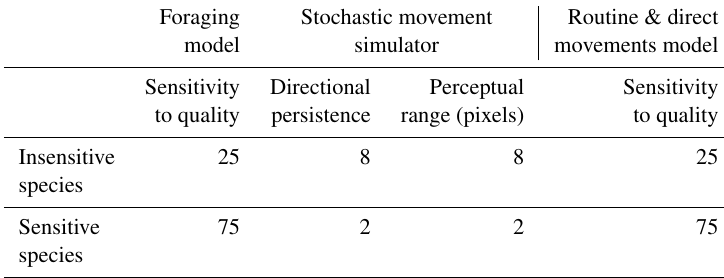
Table 1. Movement parameters of each model that are specific to the two hypothetical species. Foraging Routine &